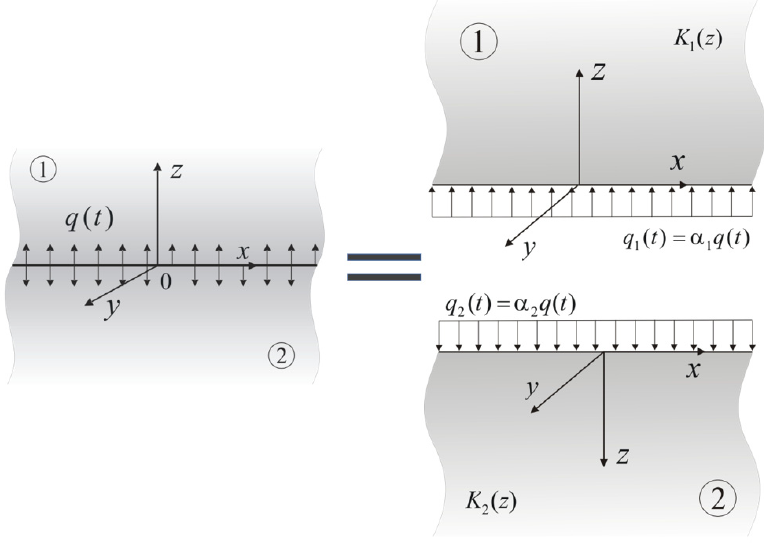
Figure 2. Scheme of separation of the friction pair elements.